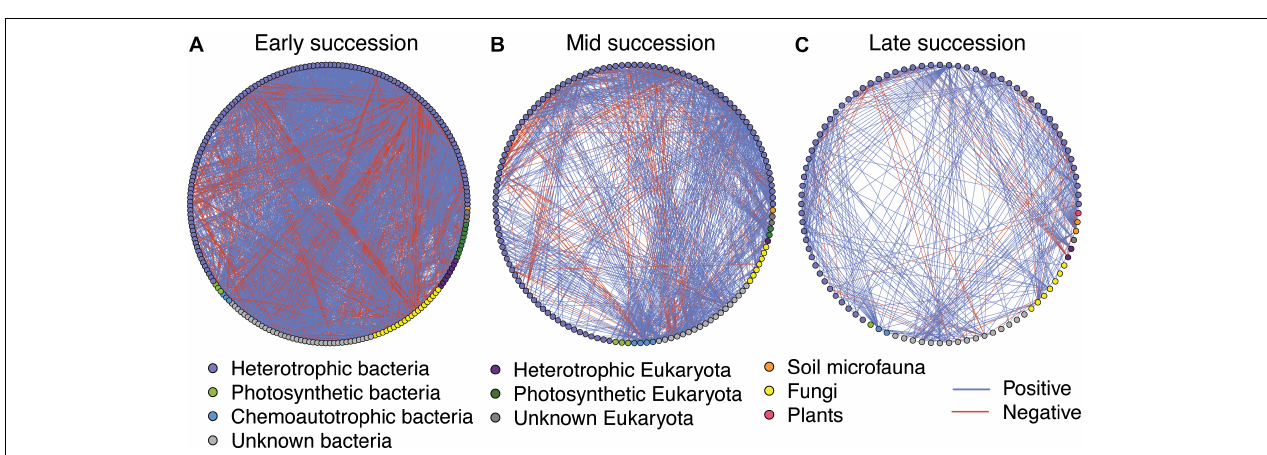
FIGURE 2 | Effect of successional stage on the relative abundance of major taxonomic groups of bacteria (A) , fungi (B) , small eukaryotes (C) , and soil microfauna (D) . Note that only abundant groups are shown in the panels. P and H refer to photosynthetic and heterotrophic groups, respectively. The effect of successional stage on each of the groups was tested using separate anovas, with P -values corrected for false discovery rate using Benjamini–Hochberg: † P < 0.10, ∗ P < 0.05, ∗∗ P < 0.01, ∗∗∗ P < 0.001. Solid lines indicate significant or nearly significant relationships and dashed lines indicate non-significant relationships.